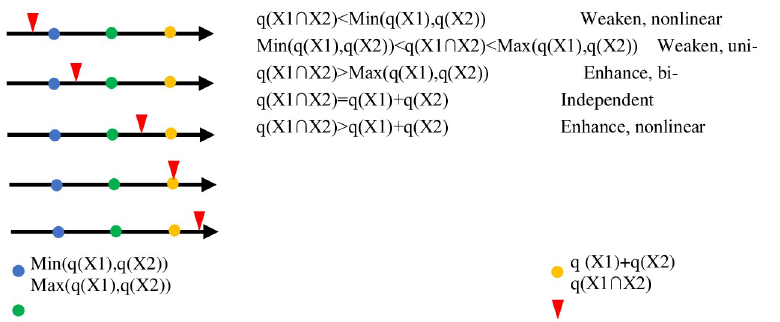
Fig 4. Redefined interaction